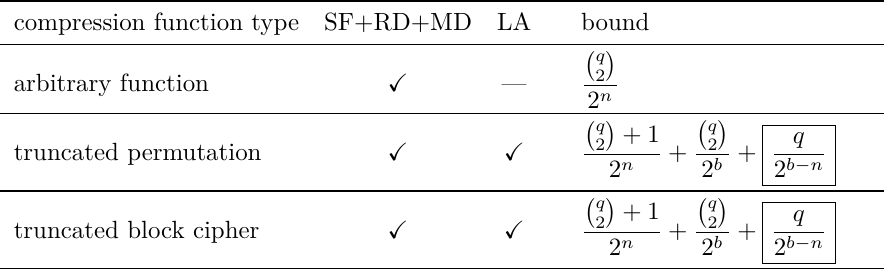
Table 1: Updated indifferentiability bounds for hashing modes of an arbitrary function, a truncated permutation or a (truncated) block cipher. The rectangles denote the additional terms. The conditions SF, RD, MD, and LA stand for subtree-freeness, radical-decodability, message-decodability, and leaf-anchoring, respectively (see the original article [DMA18] for their definitions). q is the adversarial complexity expressed as the number of primitive queries either direct or indirect, n the CV length, and b ≥ n the width of the permutation resp. the block length of the block